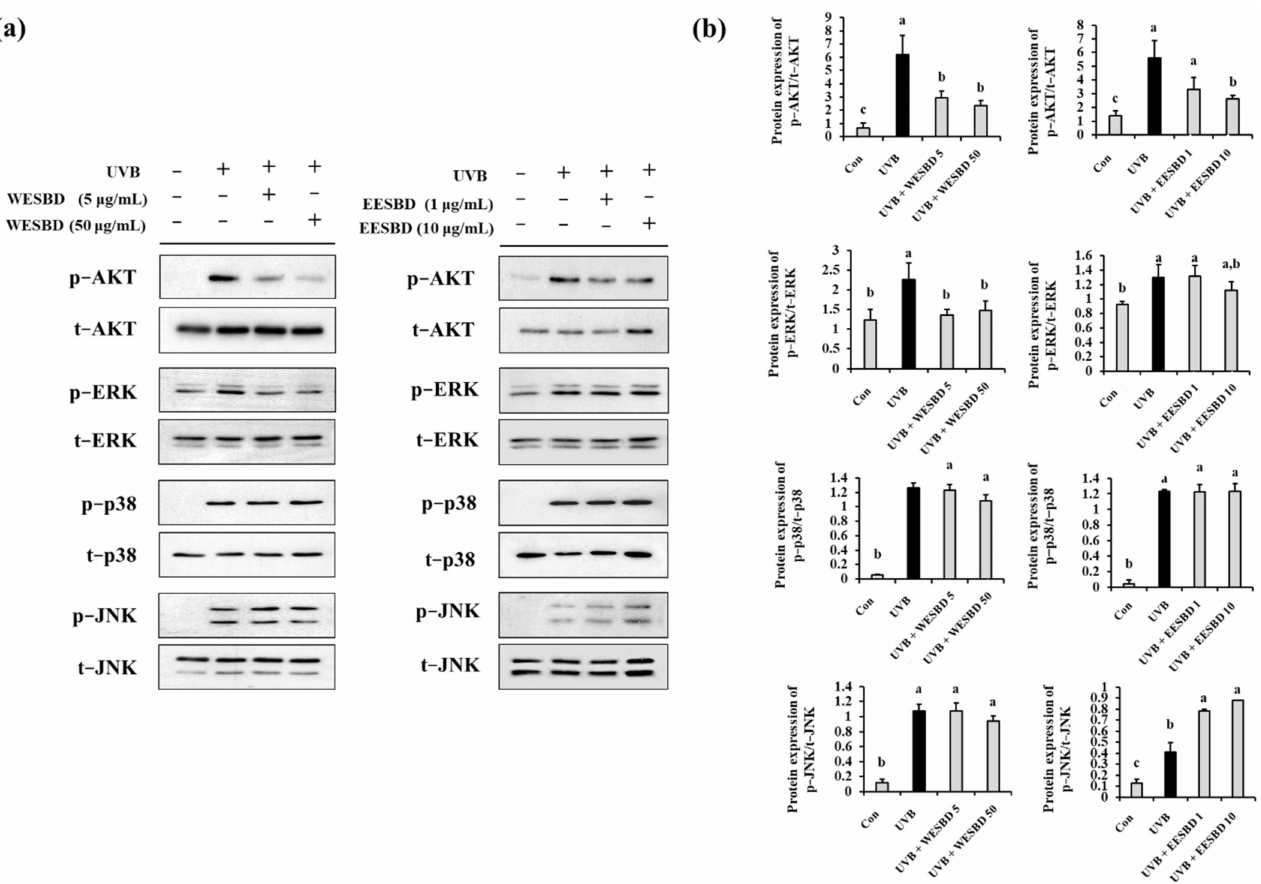
Figure 6. Ultraviolet B (UVB)-induced over-phosphorylation of protein kinase B (AKT) was sup- pressed by pretreatment with water extract of S. barbata D. Don (WESBD) or ethanol extract of SBD (EESBD). NIH-3T3 cells were pretreated with WESBD or EESBD, and the effects of UVB irradiation on AKT and mitogen-activated protein kinase (MAPK) phosphorylation were determined by Western blotting ( a ). The density of each band was calculated using the ImageJ program and tabulated ( b ). The experiments were repeated three times, with similar results. A representative result is shown. Data are presented as the mean ± SD. Different letters indicate a significant difference between groups ( p <